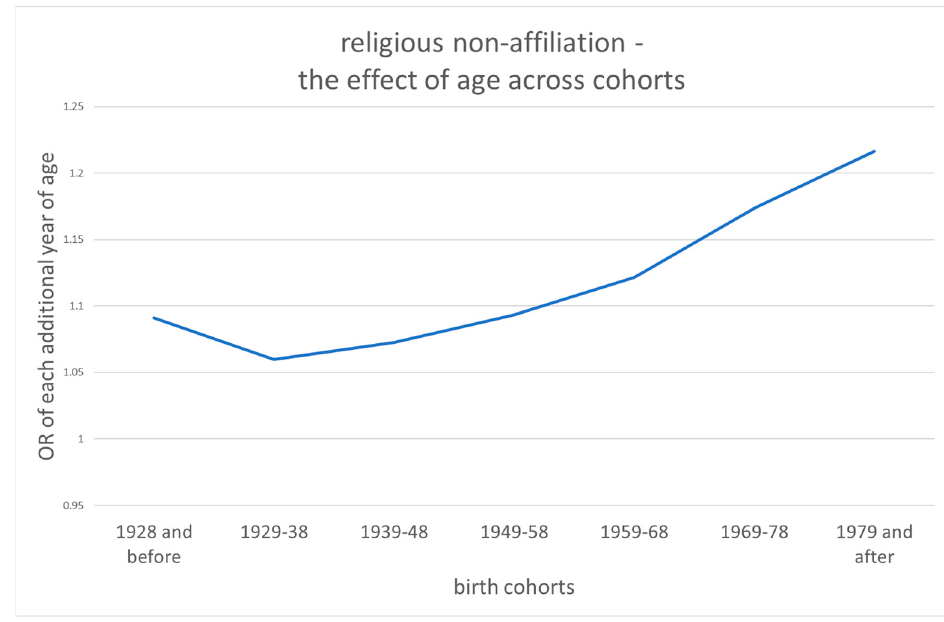
Figure 3. The effects of age across cohorts on non ‐ affiliation—odds ratios.